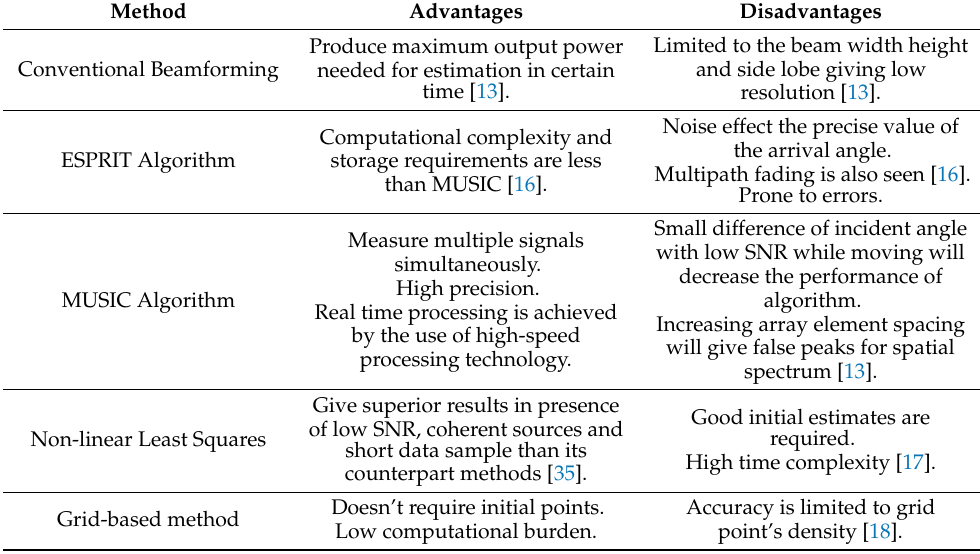
Table 3. Methods for DOA